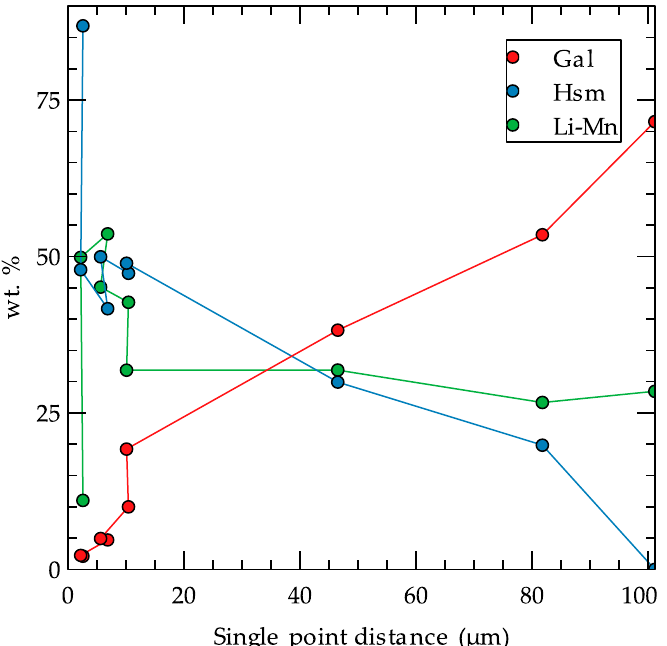
Figure 11. Fractions of the virtual compounds Mn 0.5 AlO 2 (½ galaxite, Gal), LiMnO 2 (Li-Mn), and Mn 0.5 MnO 2 (½ hausmannite, Hsm) in the grain presented in Figure